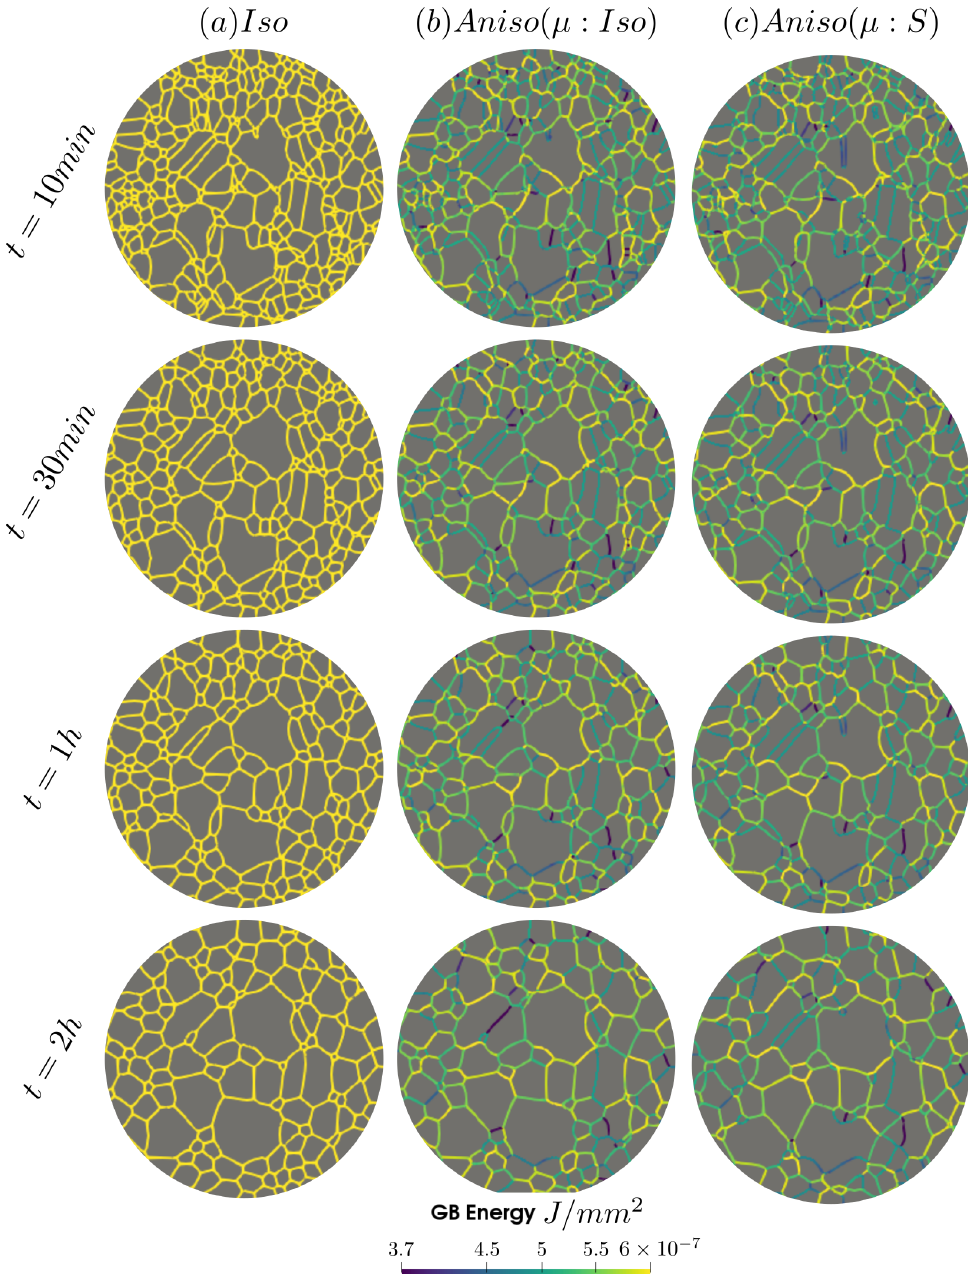
Figure 30. Microstructure evolution using the isotropic formulation and anisotropic formulation with isotropic and heterogeneous GB mobility at t = 30 min, 1 h, and 2 h. The zone shown here is encircled in blue in Figure